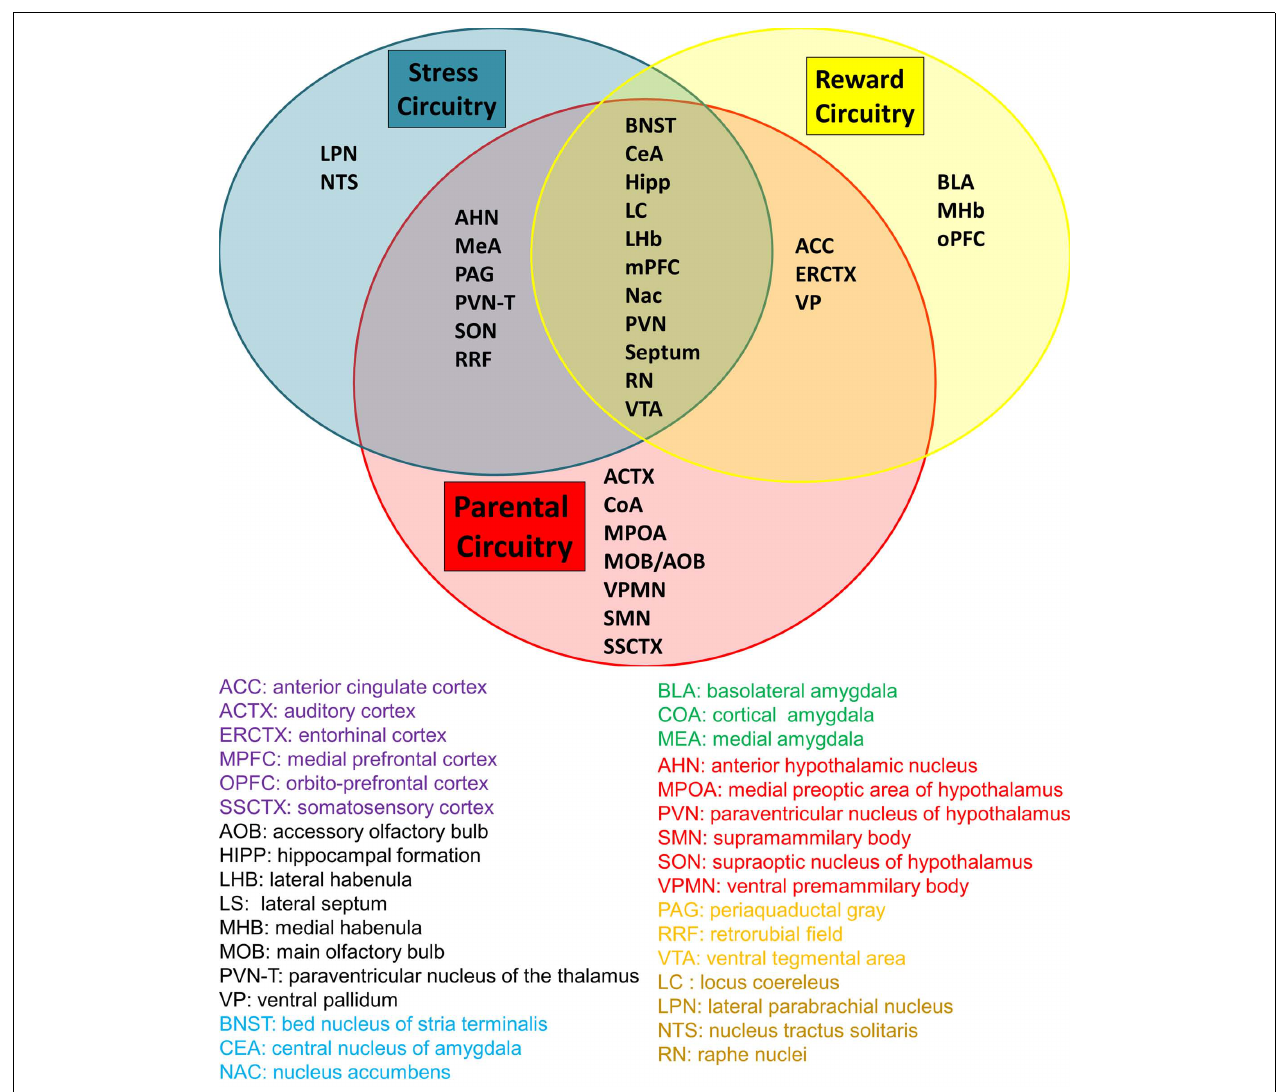
seen by the number of regions included in the Parental Circuitry circle that performance of optimal parental care (and the many types of behavior that fall into this category) requires typical functioning of the majority of the brain. Color coding in the legend indicates the anatomical brain systems in which each region